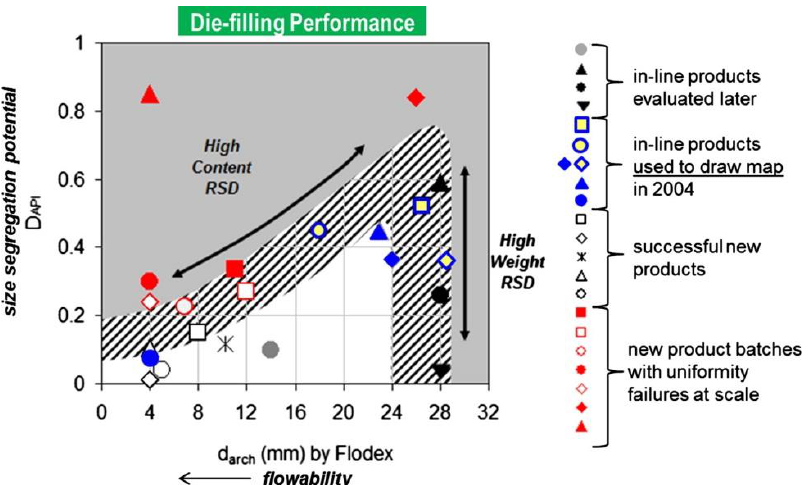
Figure 9. Practical map for estimating the risk of a loss of content uniformity based on a segregation index related to the size and active ingredient fraction in the blend (D API ) and the critical arching diameter (d arch ) determined using the Flodex flow apparatus. Gray area denotes high risk (relative standard deviation > 5%), white area — low risk, hatched region — marginal risk. Adapted with permission from [40]; published by Elsevier, 2015.